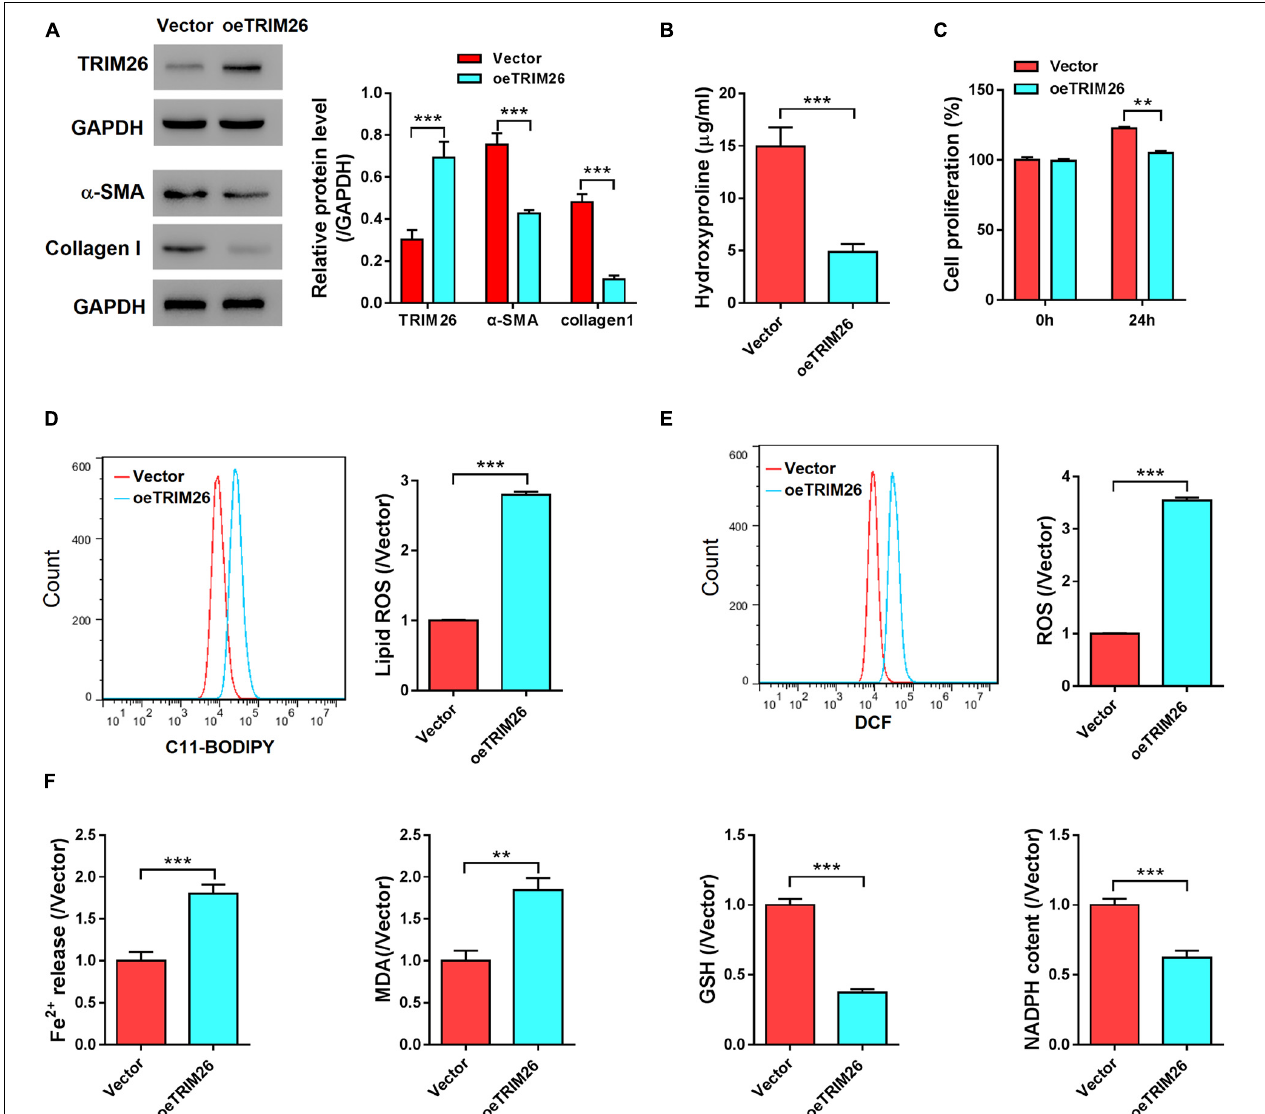
FIGURE 2 | In vitro effect of TRIM26 overexpression on HSCs. LX-2 cells were transfected with Vector or oe TRIM26 plasmid. (A) Protein expression of TRIM26, α -SMA, and collagen I by western blot analysis. (B) Hydroxyproline content in culture medium by biochemical tests. (C) LX-2 cell proliferation by CCK-8 assay. (D) Lipid peroxidation level by using the C11-BODIPY assay kit. (E) Total ROS level by using Reactive Oxygen Species Assay Kit. (F) Fe 2 + release, MDA content, GSH level, and NADPH level by biochemical tests. ** P < 0.01, *** P < 0.001.